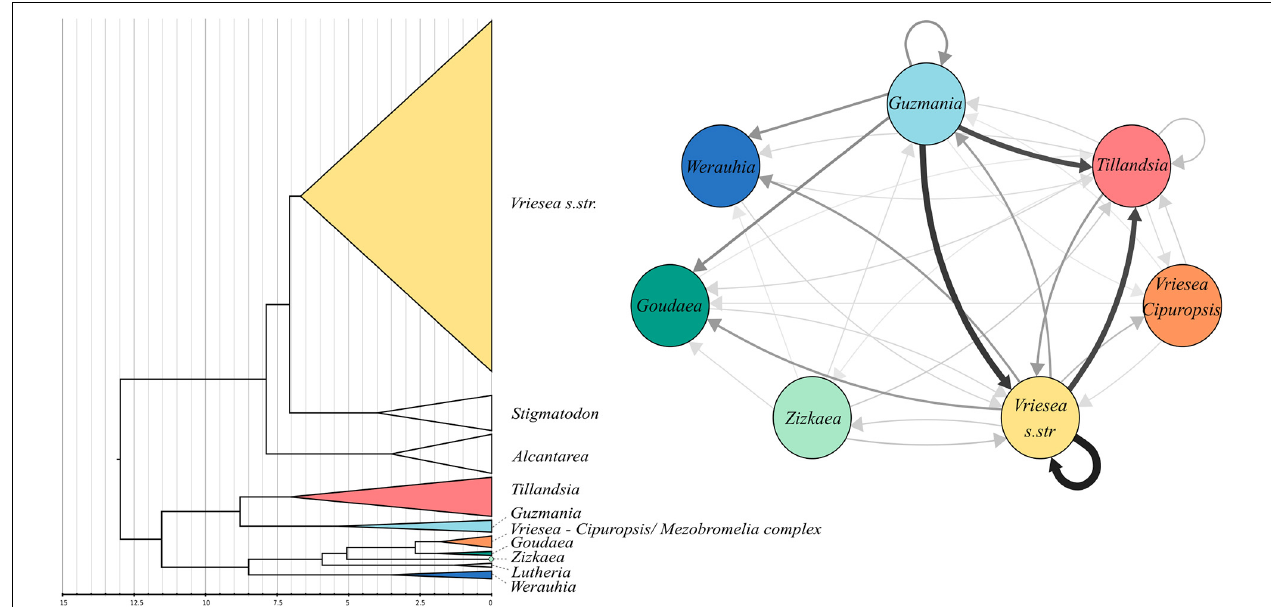
FIGURE 2 | Left: Dated nuclear phylogeny of coreTillandsioids (intrageneric branches not shown). Colors indicate clades were hybrids have been detected. Right: network diagram of the putative origin of the detected hybrids across all significant triplets identified by HyDe. The width and color of the arrows are proportional to the frequency at which one genus is detected as a parental lineageaccross all